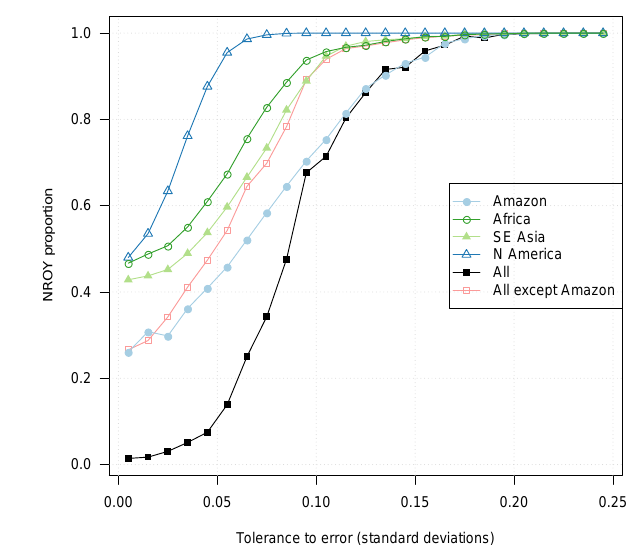
Figure 9. Proportion of NROY (not ruled out yet) input space plot- ted against “tolerance to error” – the total error budget including emulator, observational, and simulator discrepancy